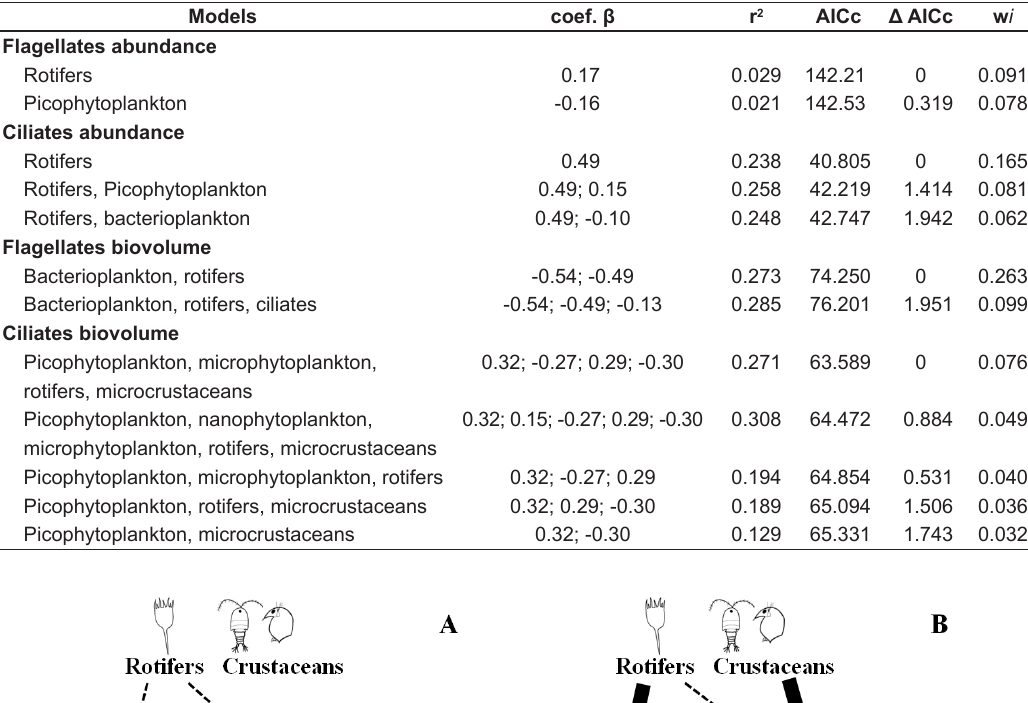
Table 2. Models considered parsimonious in explaining the abundance and biovolume of flagellates and ciliates. As a criterion for selection of models, those with AICc < 2 were considered the best approximate models, according to Burnham & Anderson (2002). For each model, AICc is the corrected Akaike Information Criterion, Δ AICc is the the difference between the AICc of each model and the minimum AICc and wi is the Akaike weight and indicates the likelihood of a particular model, among all tested, to be the most